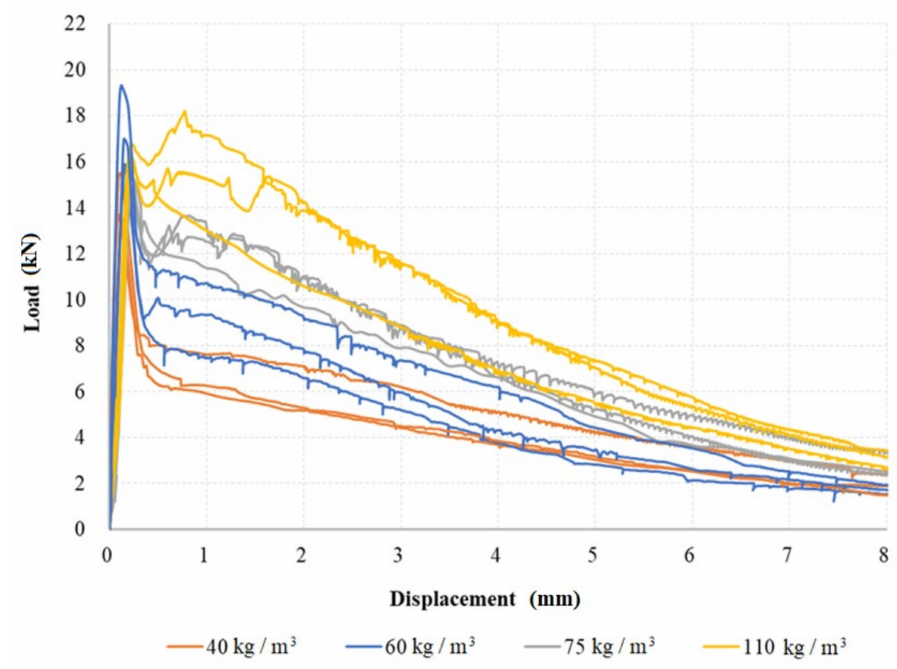
Figure 7. Load–displacement diagrams—three-point bending